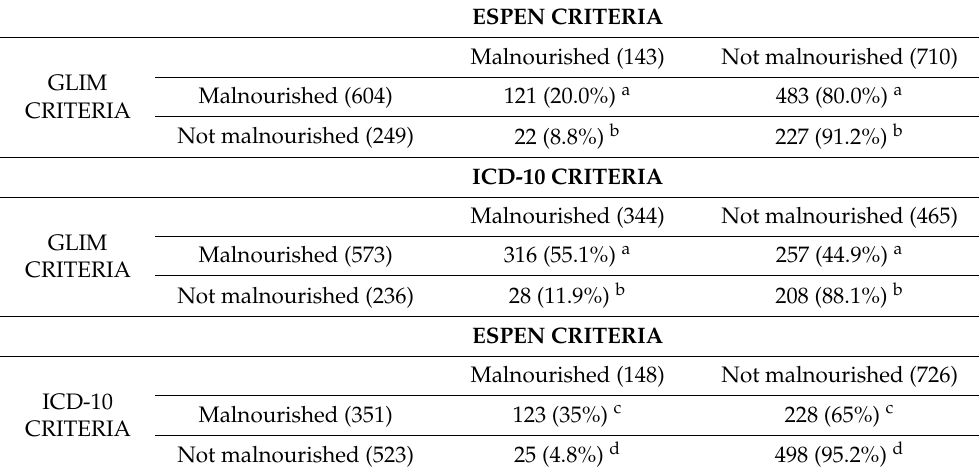
Table 3. Agreement between ICD-10, ESPEN and GLIM malnutrition diagnostic criteria.